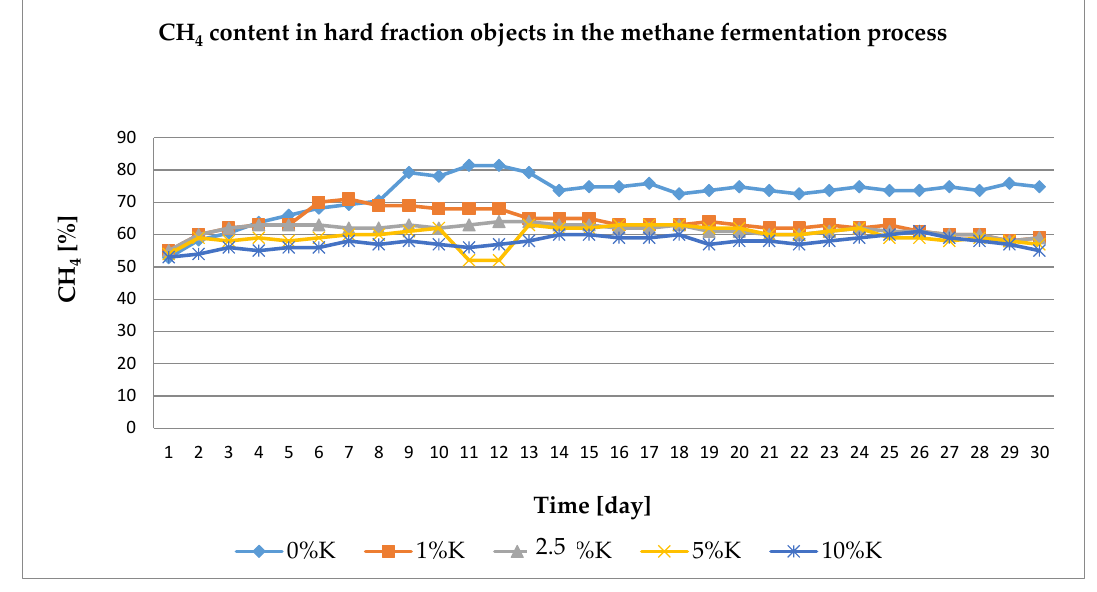
Figure 4. Methane content in soft fraction objects in the methane fermentation process.